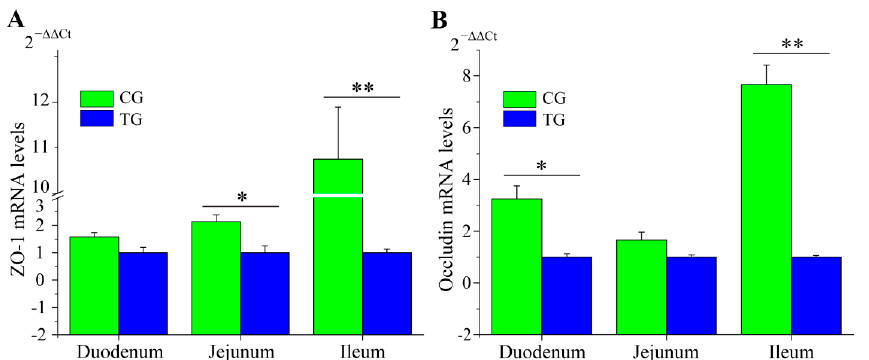
Figure 3. Tight junction protein genes ZO-1 ( A ) and Occludin ( B ) mRNA levels in the small intestinal by RT-qPCR. Data are presented as mean ± SE of three replicates (* P < 0.05; ** P < 0.01).